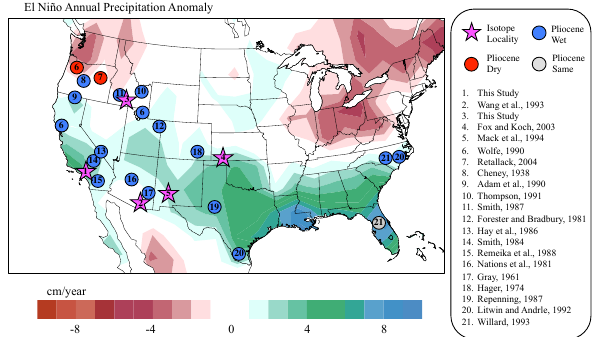
Fig. 1. Modern El Ni˜no precipitation anomalies, isotope localities, and reconstructed Pliocene conditions. Anomalous annual El Ni˜no precipitation calculated with CMAP precipitation data from 1979– 2008; CMAP precipitation data provided by the NOAA/OAR/ESRL PSD, Boulder, CO, USA, from their Web site at http://www.esrl. noaa.gov/psd/. Purple stars show isotope record localities used in this study. Blue circles represent reconstructions of wetter-than- modern Pliocene conditions, and red circles represent reconstruc- tions of drier-than-modern Pliocene